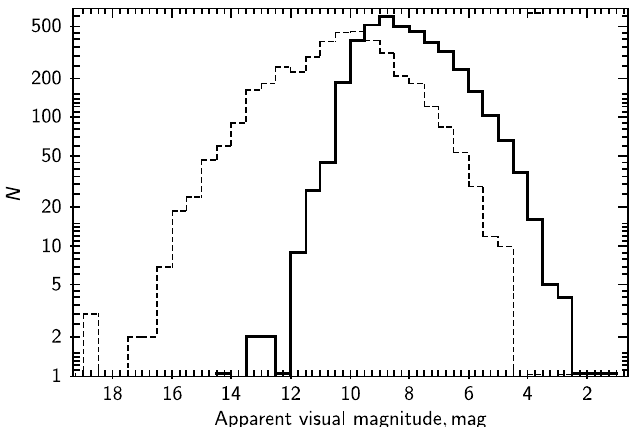
Fig. 5. Distributions of apparent magnitudes for the primaries (the solid line) and secondaries (the dashed line) in the refined set of 3676 pairs. The effect of selection by secondary magnitude is clearly seen: the number of systems starts to decrease at 10 : 5